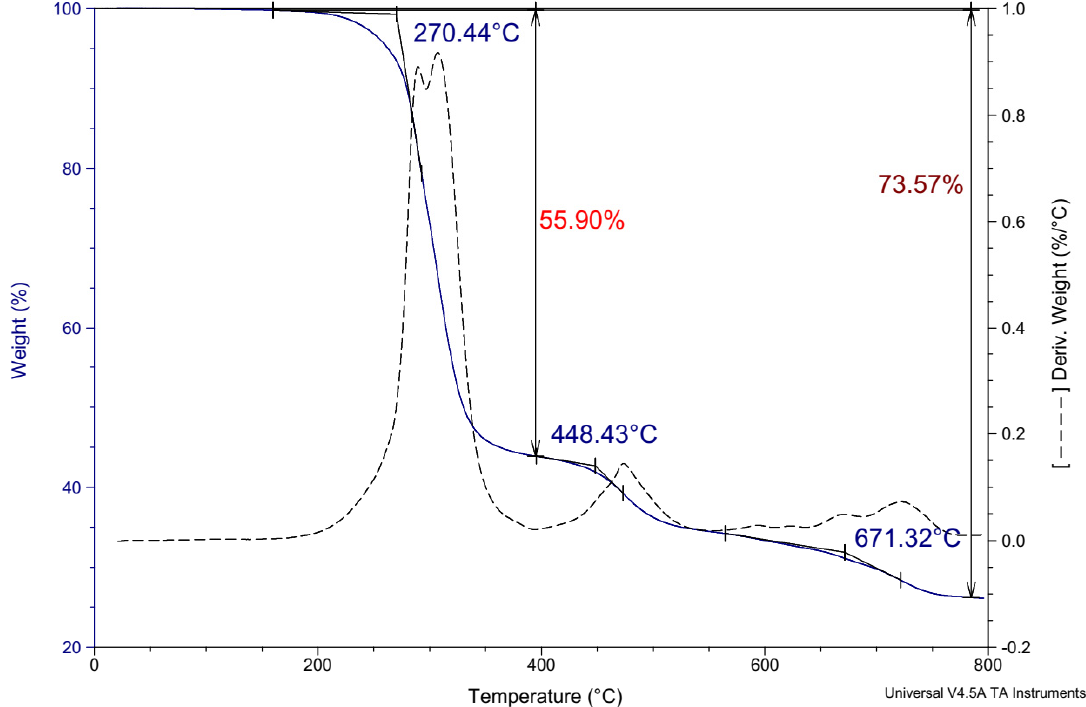
Figure 18. TGA decomposition curve for the outer sheath of a PVC coaxial power cable.